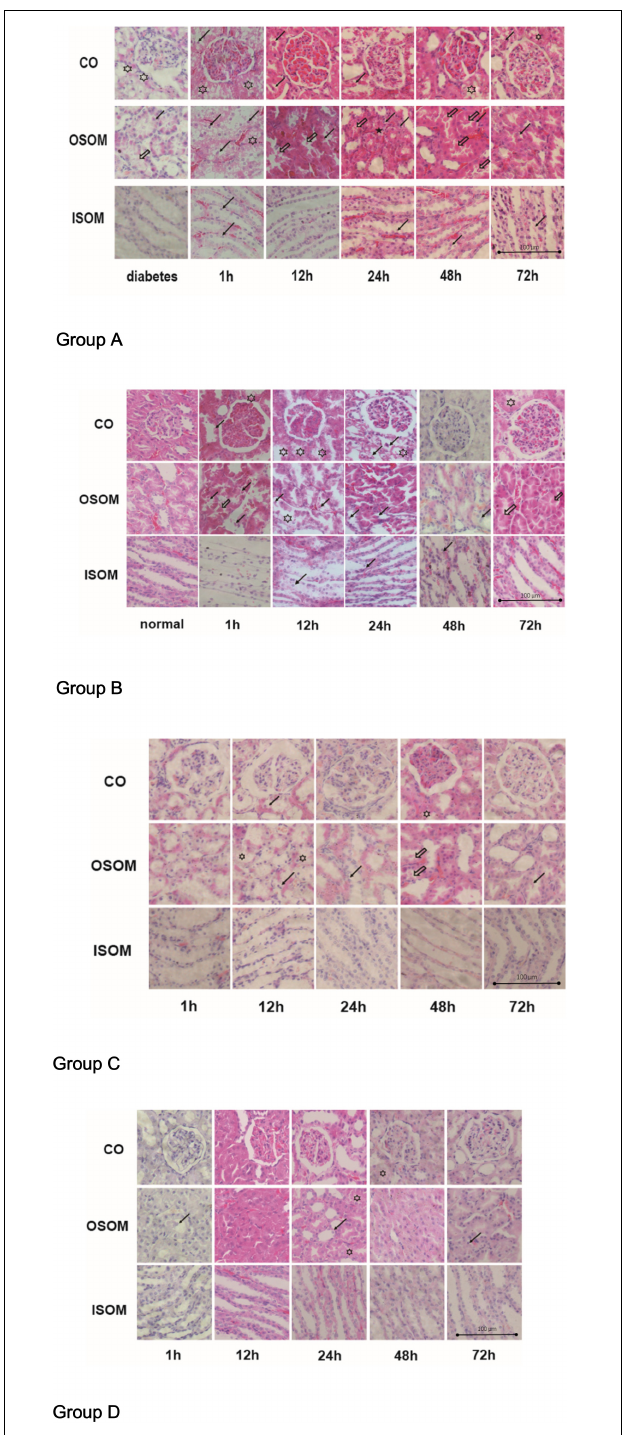
FIGURE 5 | Histological pathology of kidney, × 400. Group A diabetes+CM, Group B normal+CM, Group C diabetes+saline, and Group D normal+saline. The hollow stars show cytoplasmic vacuoles. The hollow arrows present the proteinaceous cast. The black stars show interstitial infiltration. The black arrows indicate tubular desquamation, necrosis, or atrophy. CO, cortex; OSOM, outer stripe of the outer medulla; ISOM, inner stripe of the outer medulla; CM, contrast